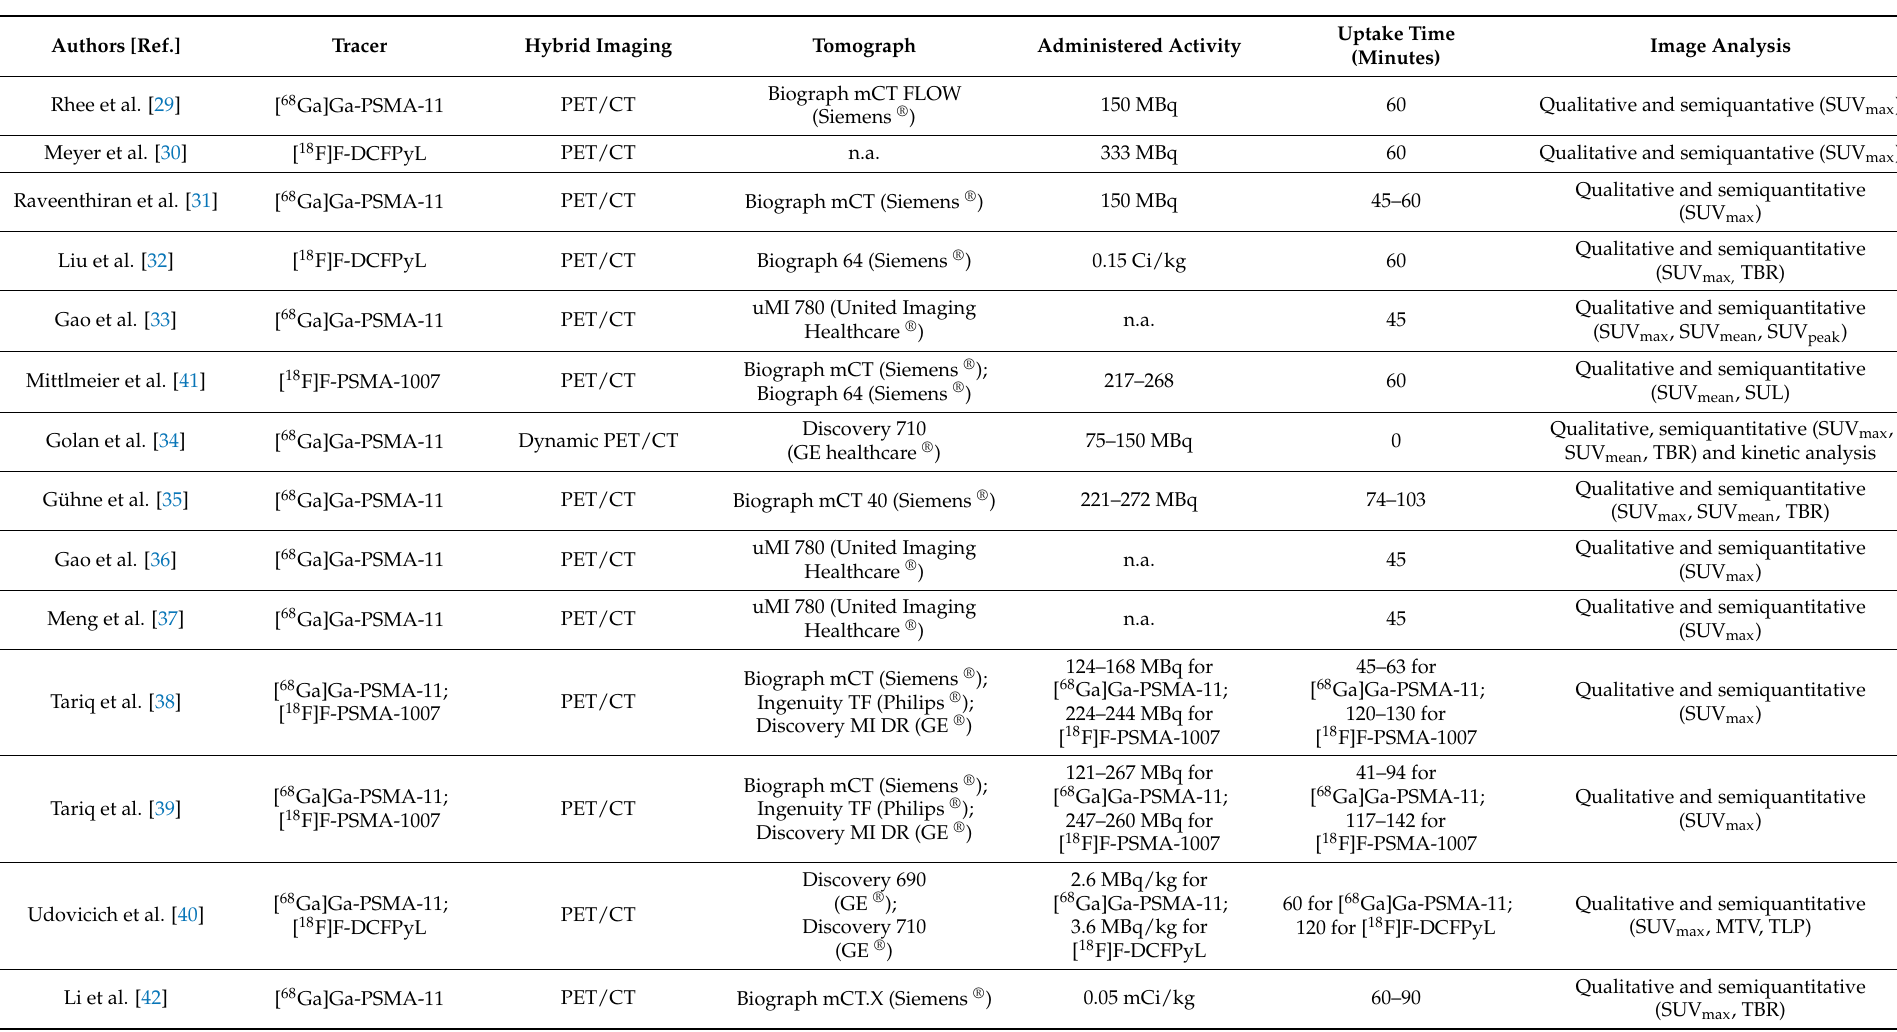
Table 3. Index test key